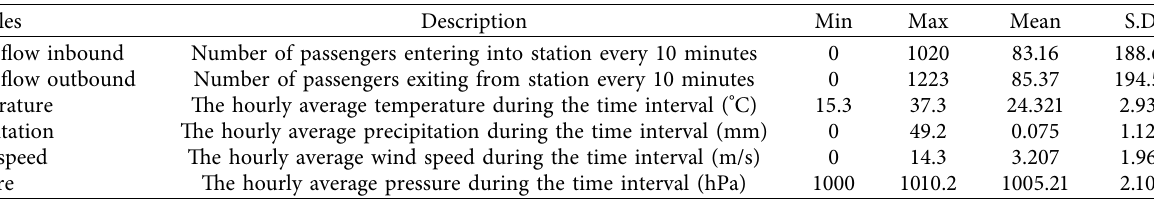
Figure 5: The study Nanjing metro line 2. Table 1: Description statistics of considered variables.